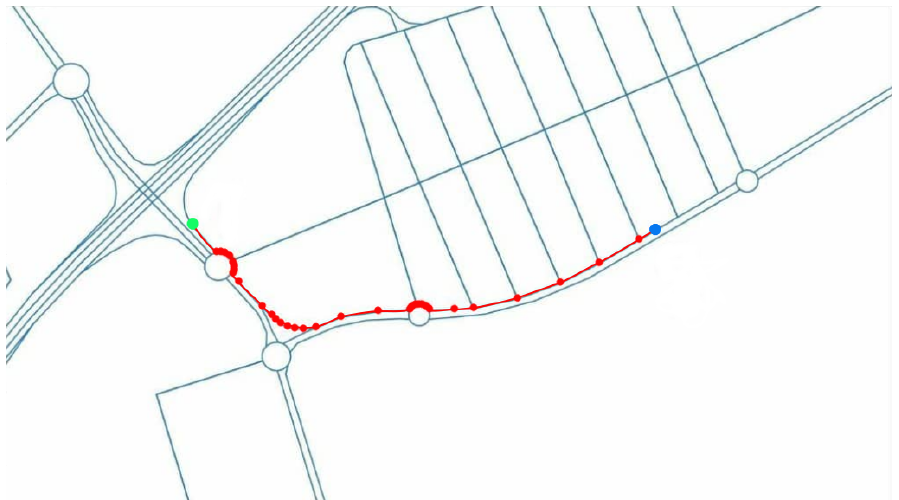
Figure 7. Global planning in OpenStreetMaps (OSM).